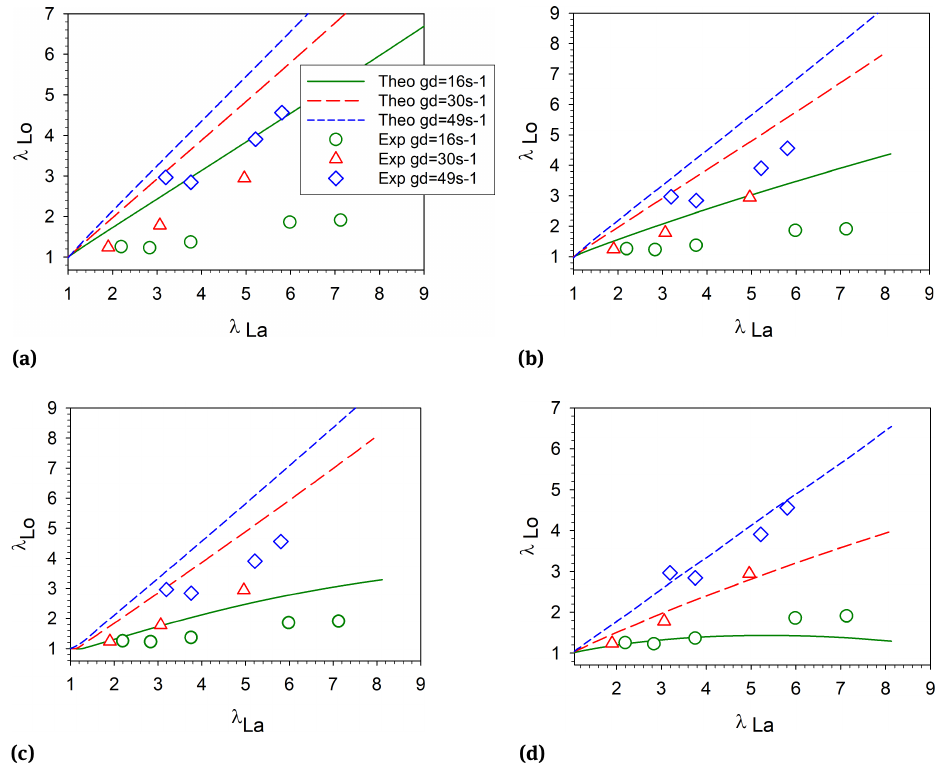
Figure 3: Stretching ratio after step shear carried out at specific shear rate values versus stretching ratio assuming aflne deformation. Experimental data from Boufarguine et al. [22] are represented with circles for ˙ 𝛾 = 16 s −1 , triangles for ˙ 𝛾 = 30 s −1 , and diamond shapes for ˙ 𝛾 = 49 s −1 . Theoretical predictions using the CV model are represented by solid lines for ˙ 𝛾 = 16 s −1 , long dashes for ˙ 𝛾 = 30 s −1 and short dashes for ˙ 𝛾 = 49 s −1 . In parts a, b, c and d, lines are predictions of the original CV model, the CV model combined with the Carreau-Yasuda shear thinning model, the CV model combined with the Bautista et al. model and the CV model combined with the power law with exponent value − 0.73, respectively.